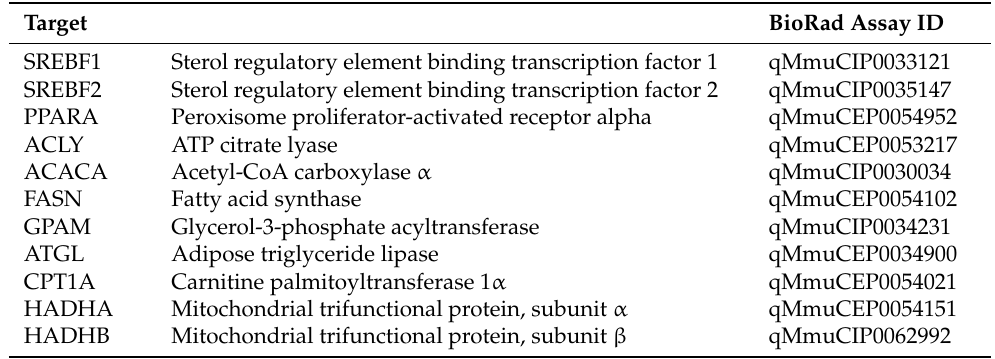
Table 2. Primers used for real-time